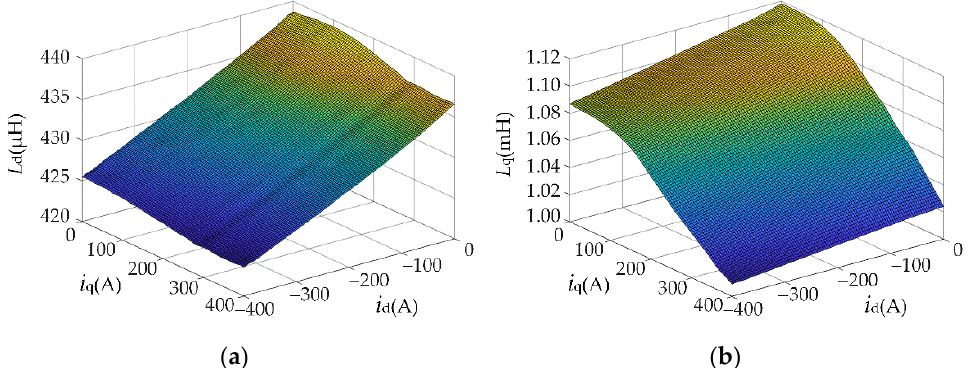
Figure 2. Relationship between dq-axis inductance and dq-axis current: ( a ) d-axis inductance, ( b ) q-axis inductance.